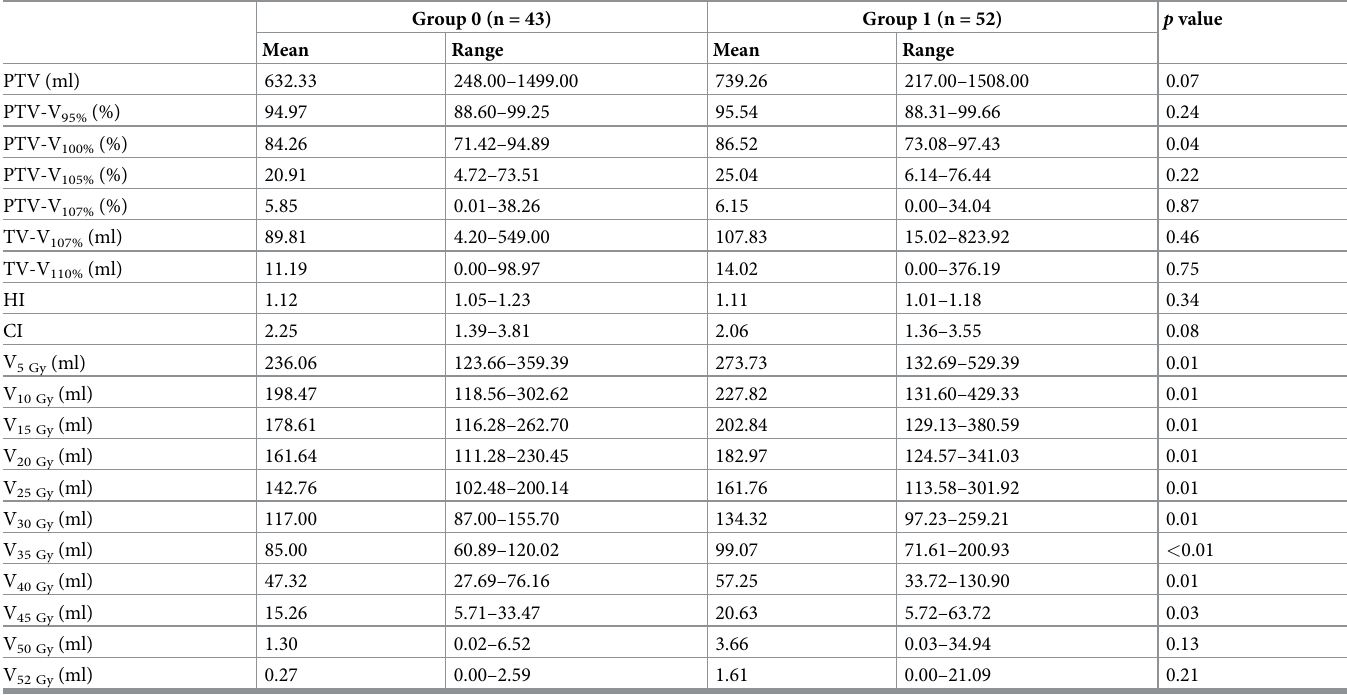
Table 2. Analyses of dosimetric parameters for patients without and with grade 2+ radiation